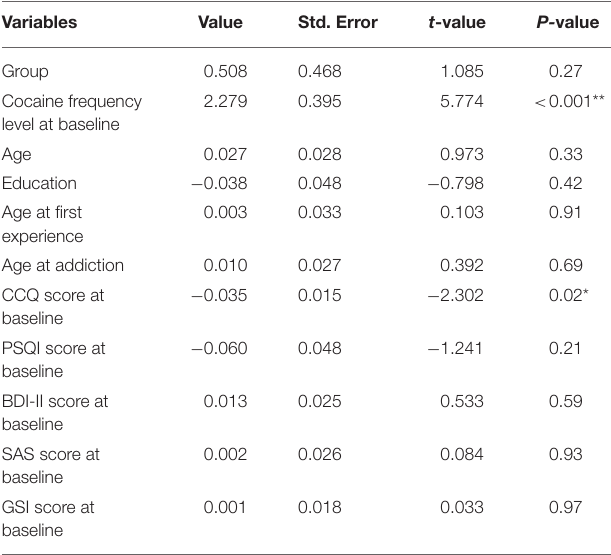
TABLE 2 | Coefficient table of the ordinal logistic regression for examining the best predictor of change in cocaine frequency level.